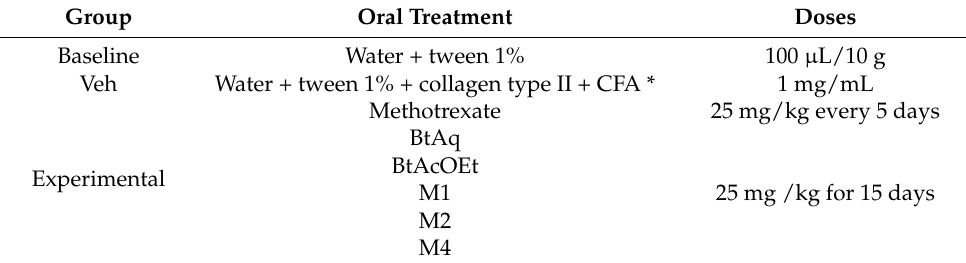
Table 2. Groups and experimental treatments with collagen type II and CFA. Group Oral Treatment Doses Baseline